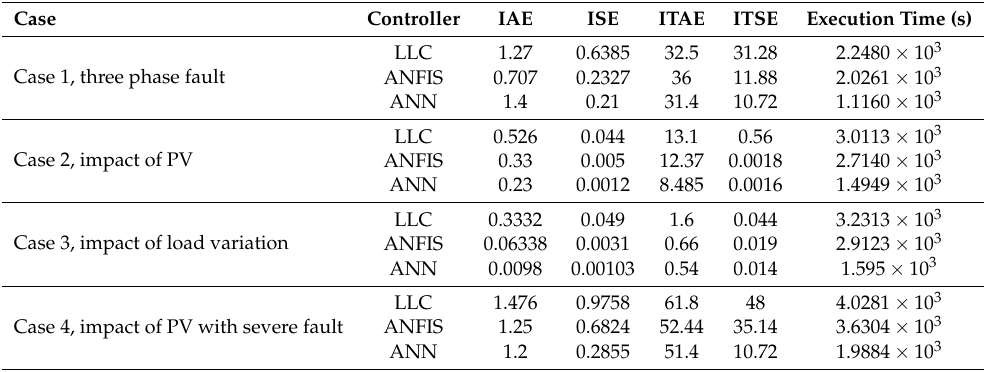
Table 4. Oscillation damping performance